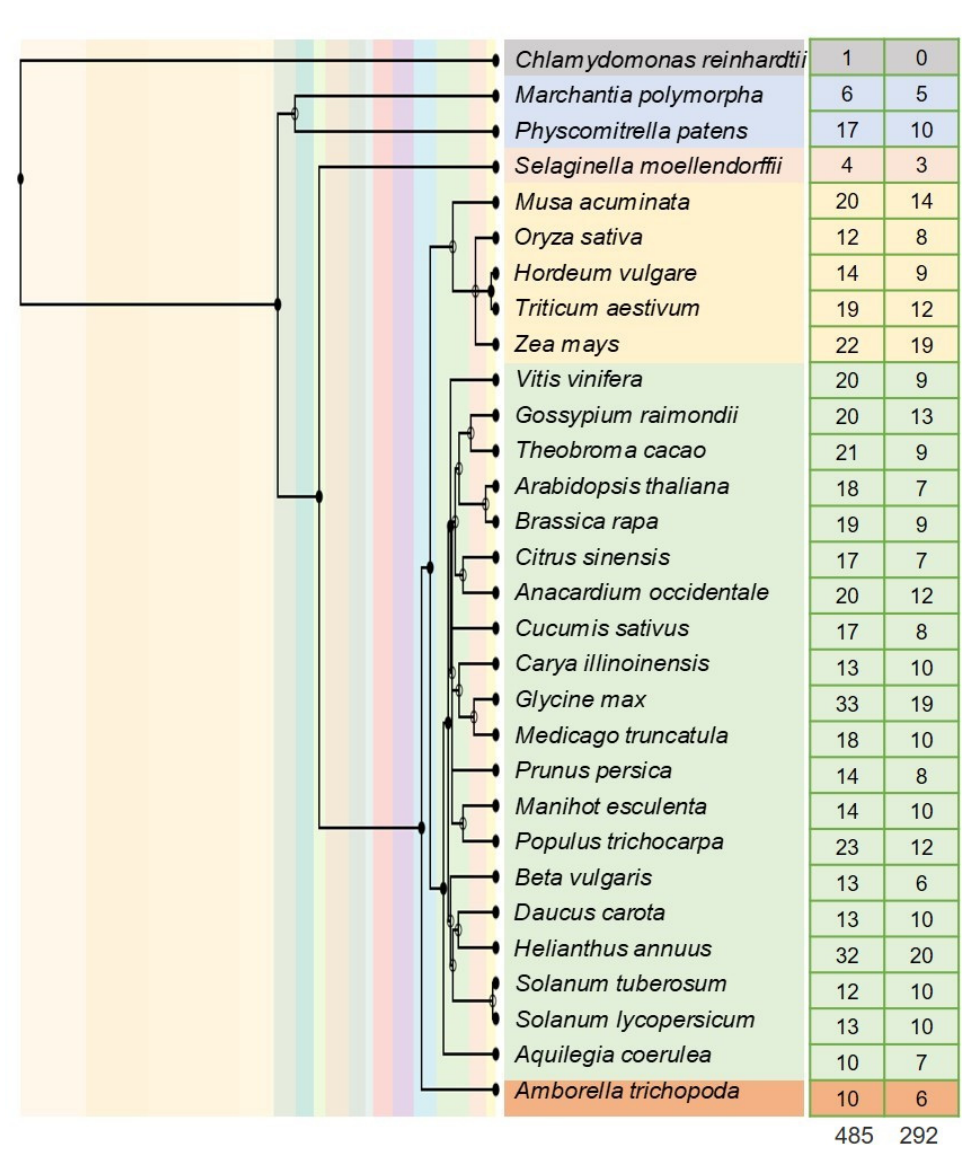
Figure 1. The number of BAG family in 30 plant species. The number of BAG proteins in 30 plant species and each group were shown on the right. The whole genomic data come from Phytozome 13. The number of BAG conserved domain analyzed by batch CD search were shown on the right. The species evolution tree was constructed by TimeTree 5 Beta (http://www.timetree.org, accessed on 10 January 2022).